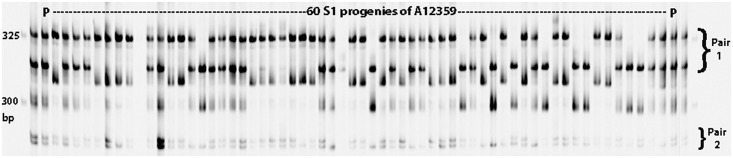
A gel image of A12359 and its 60 progenies amplified with an SSR CDAAC7-2693/2694.Four bands of A12359 segregated in two pairs labeled on the right side of the gel, “Pair 1” for bands in the range of 300 and 325 bp, and “Pair 2” for the other pair smaller than 300 bp. P represents the parent A12359 common bermudagrass. Size markers are labeled for the first lane on the left side.